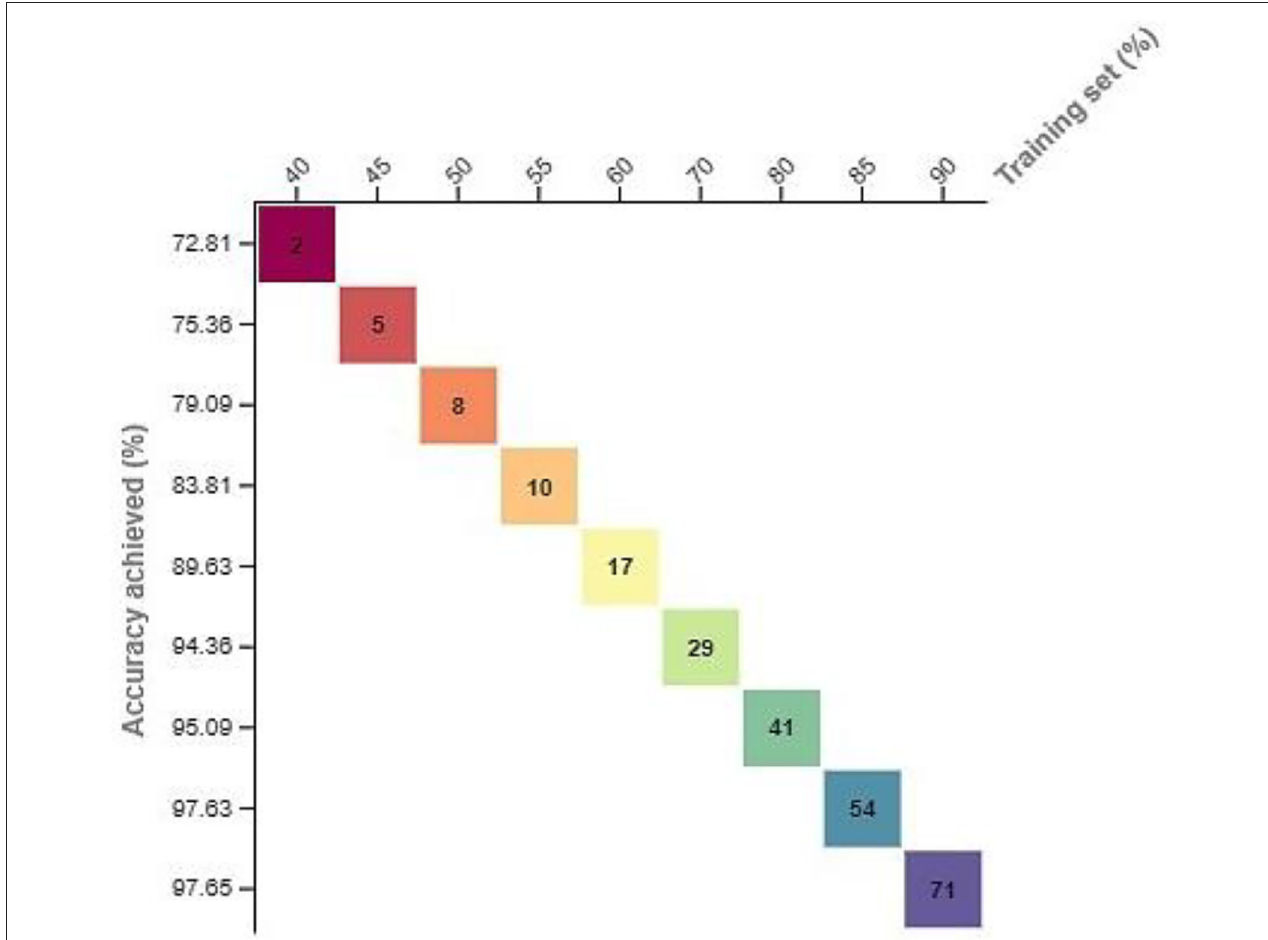
FIGURE 4 | Evolution of the suggested model using different training and test